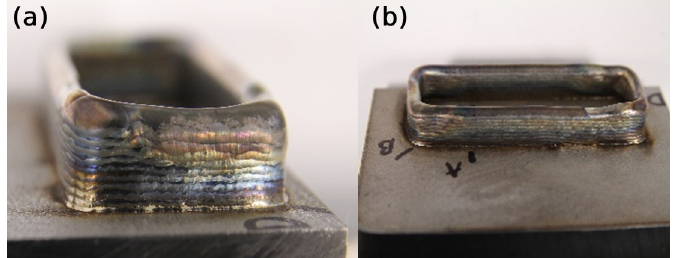
Figure 7. Experimental layers deposit; ( a ) front view, ( b ) side view. Figures 8 and 9 show the results of the prediction model height and width respectively. The figures show the prediction results for both the training data set (layers 1 to 10—red circle) and the prediction data set (layers 11 to 15—black circle).